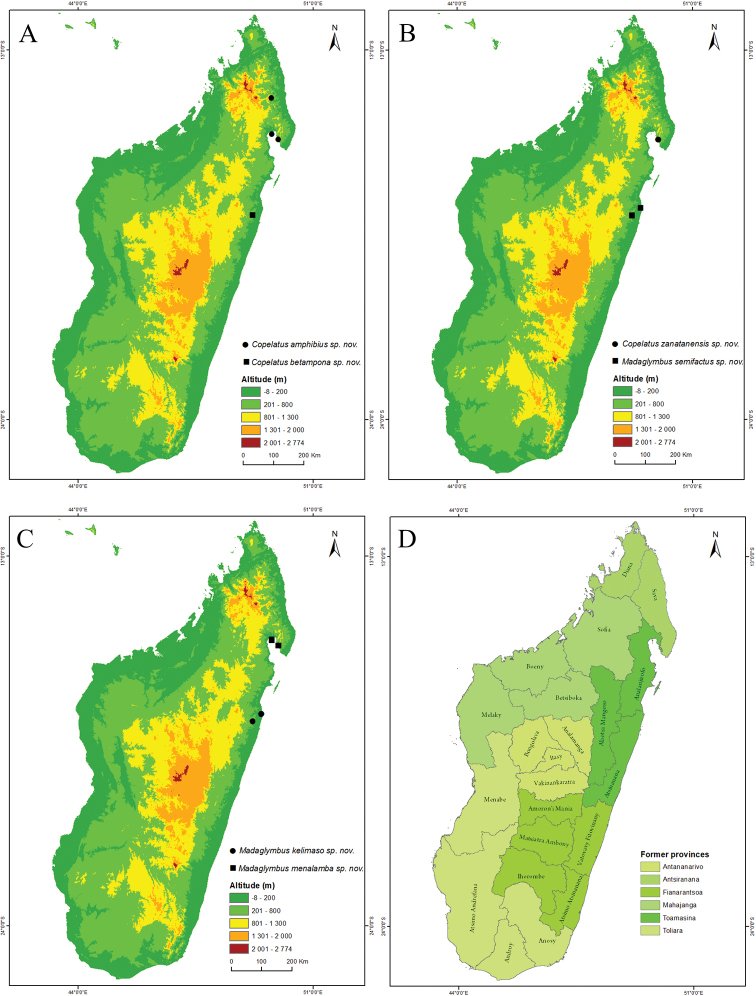
Maps of Madagascar with species distributions and administrative divisions. ACopelatus
amphibius sp. nov. (circle), Copelatus
betampona sp. nov. (square) BCopelatus
zanatanensis sp. nov. (circle), Madaglymbus
semifactus sp. nov. (square) CMadaglymbus
kelimaso sp. nov. (circle), Madaglymbus
menalamba sp. nov. (square) D current 22 regions and six former provinces of Madagascar.